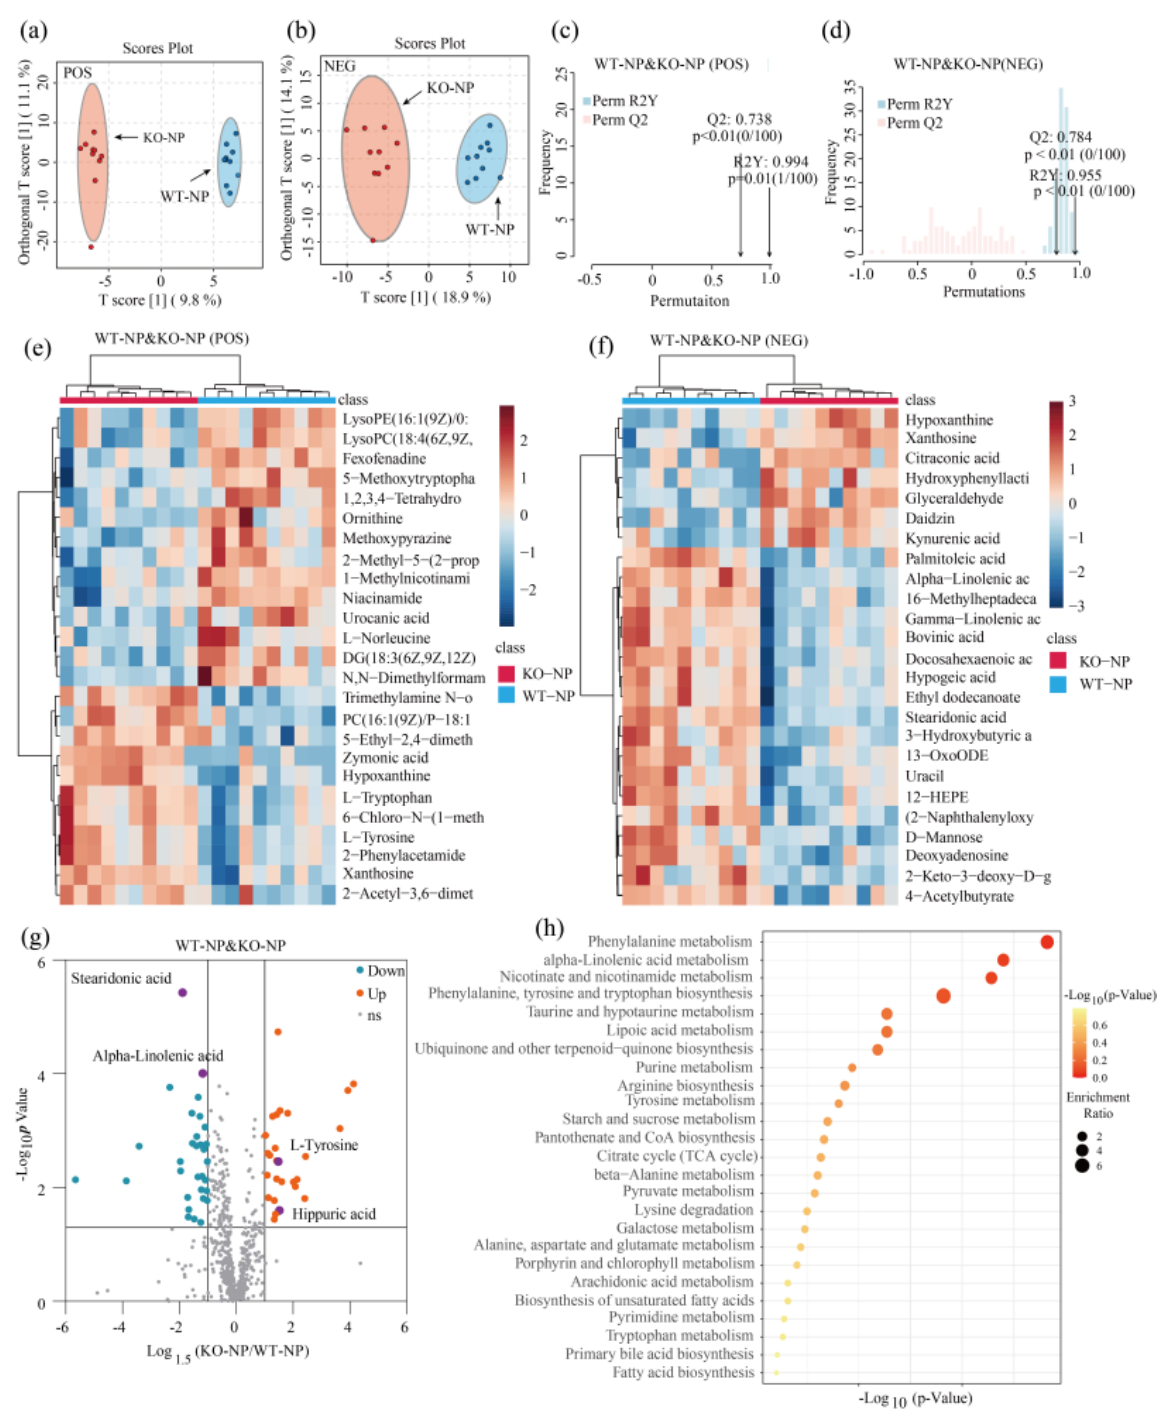
Figure 3. Knockout of GPRC6A altered metabolic profiles of mice fed 20% dietary protein. ( a , b ) OPLS–DA score plots showed good separation of clusters between WT–NP and KO–NP under POS or NEG mode. ( c , d ) Permutation test verified the reliability of OPLS–DA, with 100 permutations. ( e , f ) Heatmap of metabolites with the most significant differences based on p -values (Top 25). ( g ) Volcano plot shows the differential metabolites between WT–NP and KO–NP; the vertical axis represents the p -value ( − log 10 p -value), and the horizontal axis represents the fold change (Log 1.5 FC), where FC is defined as the ratio of levels in KO–NP to WT–NP. ( h ) Overview of enriched metabolite sets (Top 25); the horizontal axis represents the p -value ( − log 10 p -value); enrichment ratio is the ratio of observed hits to expected